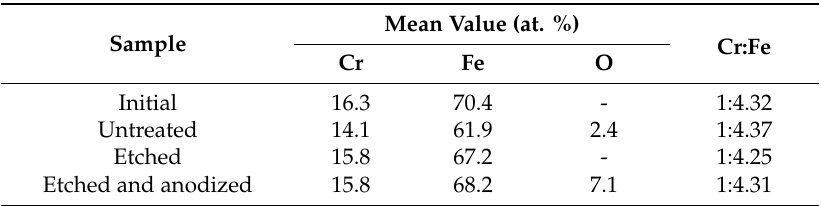
Table 1. EDX data for the surface composition of the initial sample and those obtained after anodizing of amorphous Fe70Cr15B15 alloy (AA) in ionic liquid (IL) used without pretreatment (untreated) and after pretreatment with benzoic acid bu ff er solution (BB) (etched), etched and anodized in IL. Mean Value (at. %) Sample Cr:Fe Cr Fe O Initial 16.3 70.4 1:4.32 Untreated Etched Etched and